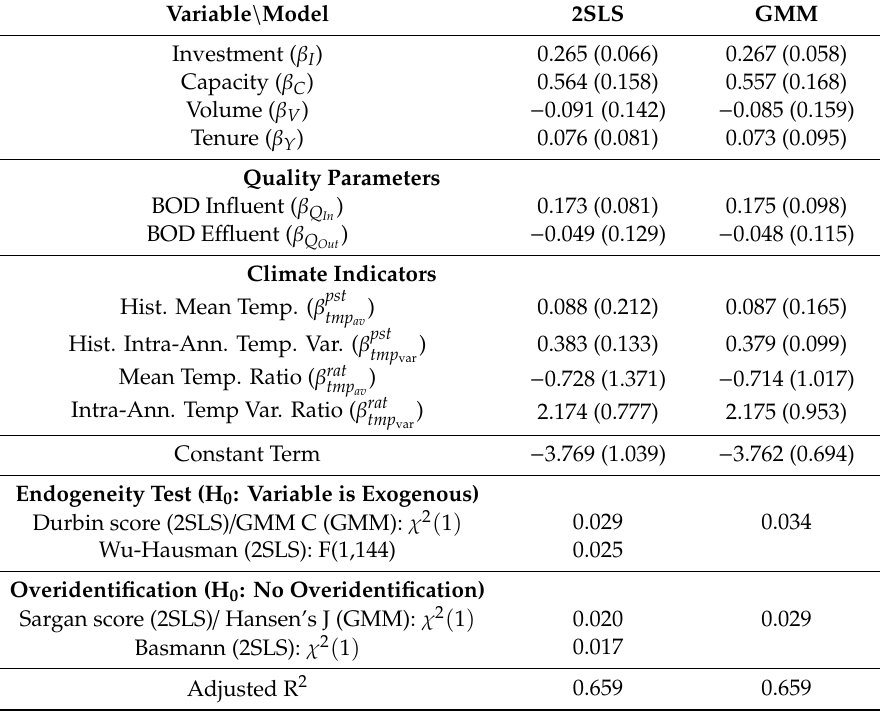
Table A3. Instrumental variables regression for identifying endogeneity, di ff erent estimation methods.